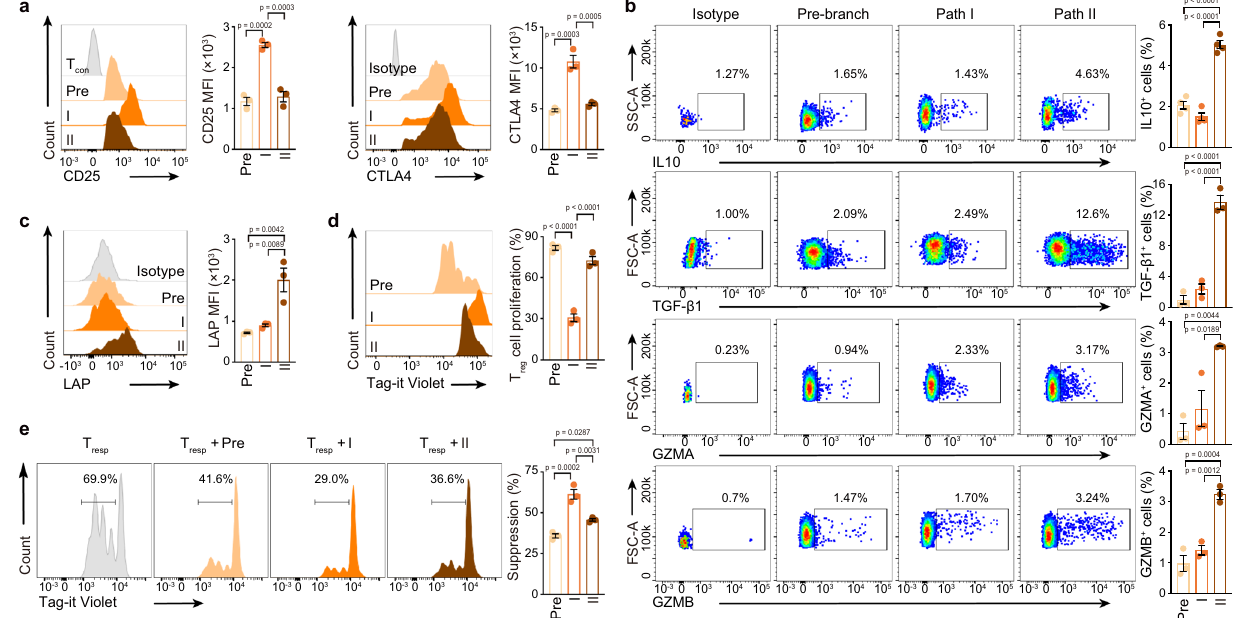
Fig. 4 In vitro assay of T reg cell paths. a − c Flow cytometry and its quanti fi cation of the indicated proteins in each HD PB T reg cell path (CD25: n = 3, CTLA4: n = 3, IL10: n = 4, TGF- β 1: n = 3, GZMA: n = 3, GZMB: n = 3, LAP: n = 3). d The proliferation of HD PB T reg cell paths. The Tag-it Violet dilution